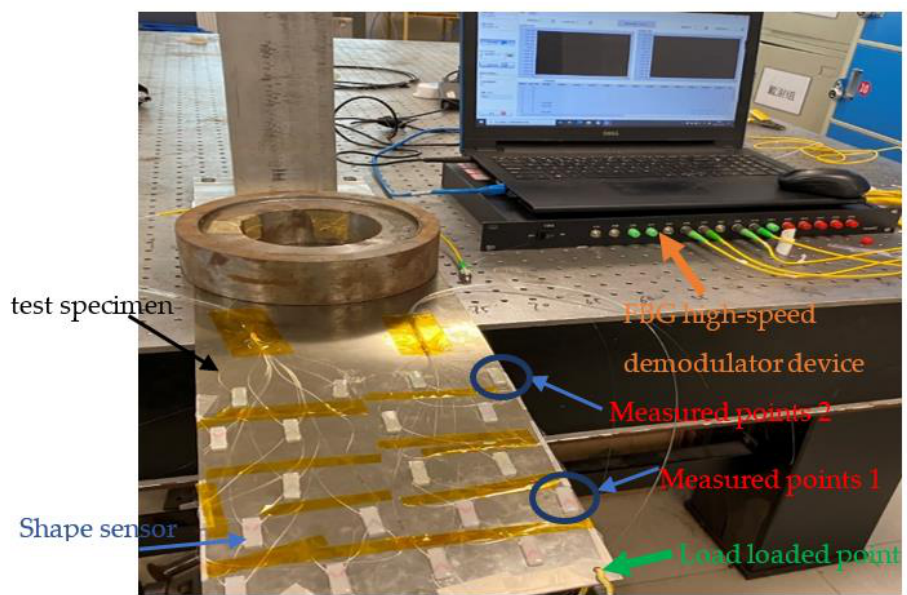
Figure 19. Shape sensor reconstruction experiment platform.